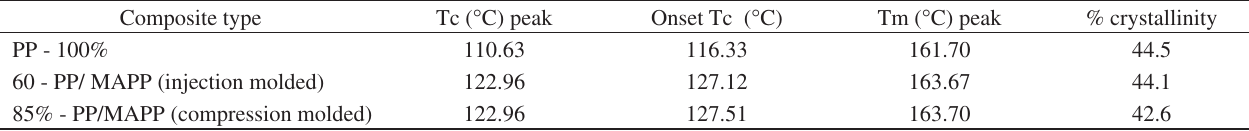
Table 2. Crystallinity data of the plastic matrix for kenaf composites. (MAPP was used as the compatibilizer/ coupling agent; Pure PP crystals- crystallization enthalpy = 209 J/g). 20 Composite type